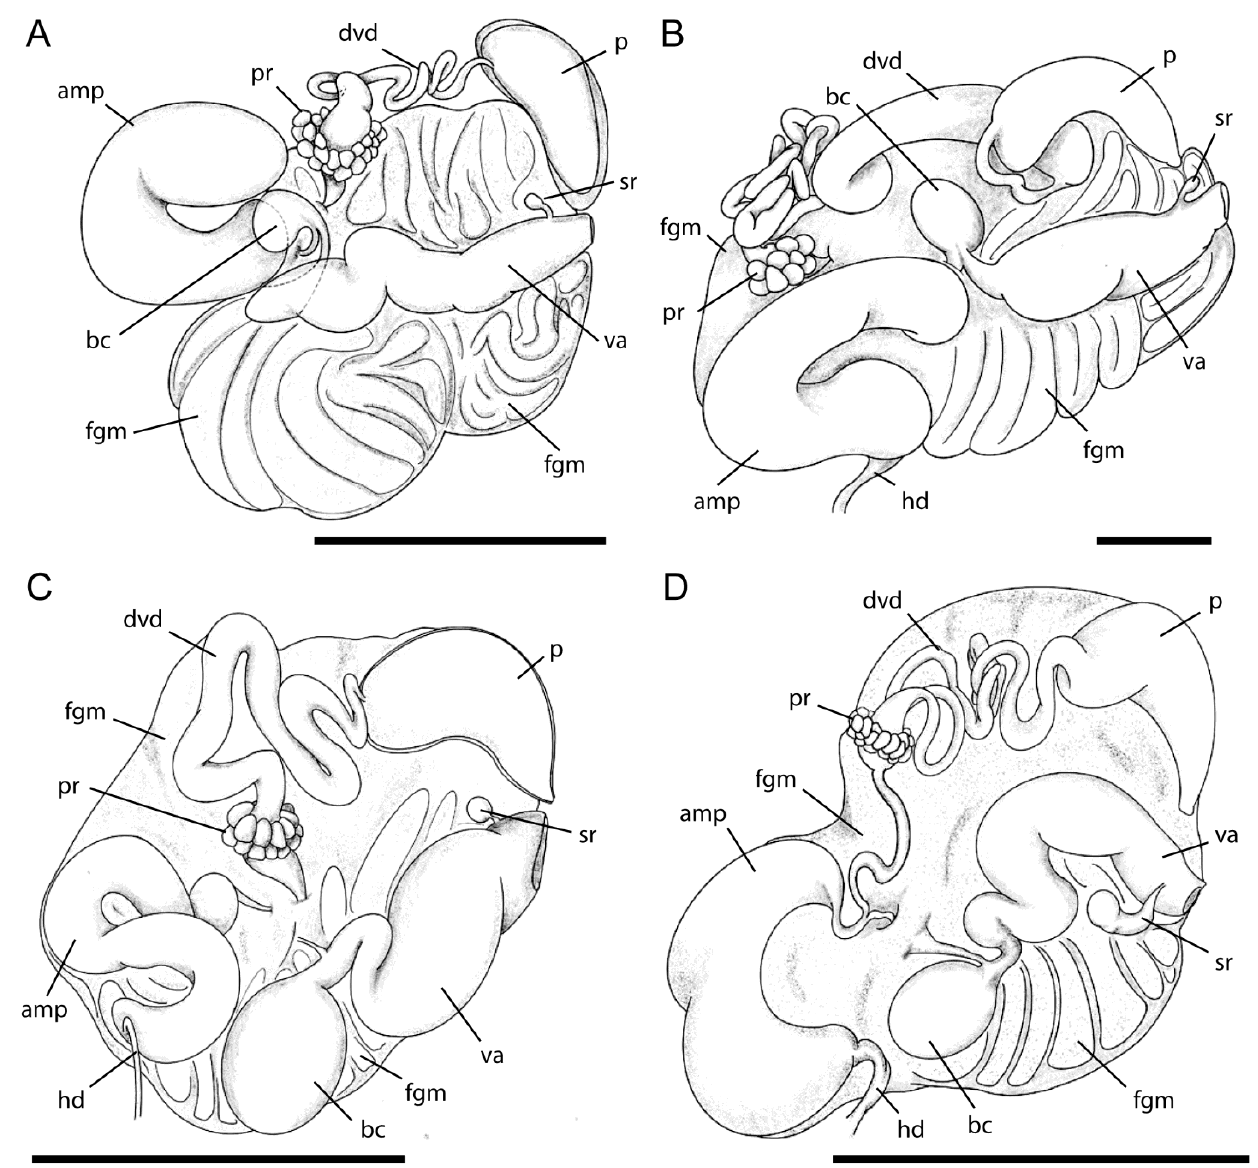
Figure 3. The reproductive system in four new species. ( A ) — Dendronotus valdesi sp. nov. ( B ) — Den- dronotus igori sp. nov. ( C ) — Dendronotus pseudodalli sp. nov. ( D ) — Dendronotus babai sp. nov.